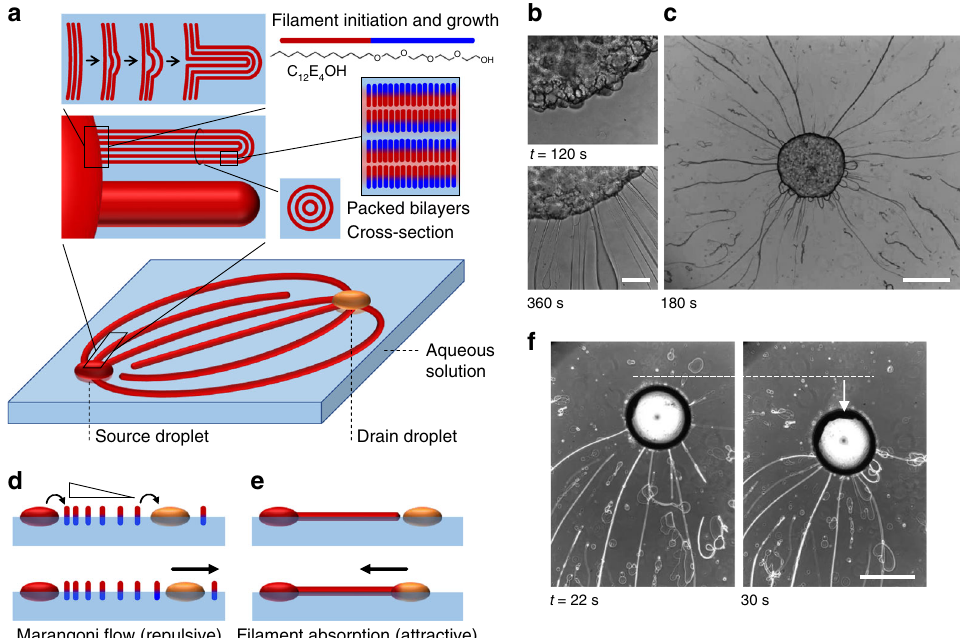
Fig. 1 Marangoni fl ows and fi laments direct positioning. a In the amphiphile source droplet (red sphere), the C 12 E 4 OH amphiphile forms closely packed bilayers. At the boundary of the droplet that is fl oating on water, the amphiphiles take up water (light blue), the packed bilayers buckle, and form long fi laments consisting of bilayers. b , c Optical microscopy images of fi lament extrusion from the amphiphile source droplet, after deposition at an aqueous sodium alginate solution at t = 0 s. The scale bar in b represents 200 μ m; the scale bar in c is 1 mm. d Concomitant to the fi lament growth, individual amphiphile molecules are released from the source droplet (red sphere) to the air – water interface. Subsequently, these amphiphiles are depleted at the drain droplet (orange sphere), such that a Marangoni fl ow emerges that pushes the source and drain droplets apart. e The drain, however, is pulled back to the source upon absorption of the fi laments. A dynamic organization emerges when the repulsive (Marangoni fl ow) and attractive forces ( fi lament absorption) match. f Upon fi lament absorption, the drain droplet (deposited at t = 0 s) is pulled towards the source — positioned in the bottom with respect to the area that is featured in the microscopy images. The scale bar represents 1